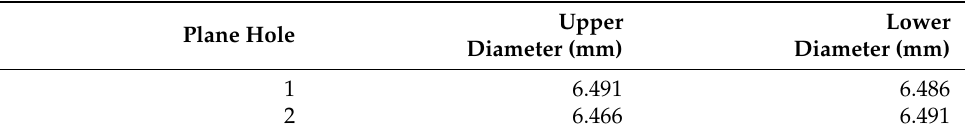
Figure 1. Stereolithography reference images with indicative length measurements in millimetres (.stl) of implant surgical guides. ( a ) Upper; ( b ) lower. Table 1. Reference measurements for diameter of each plane hole based on reference STL files. All fifty-five samples were compared to the upper and lower reference measurements to determine error in